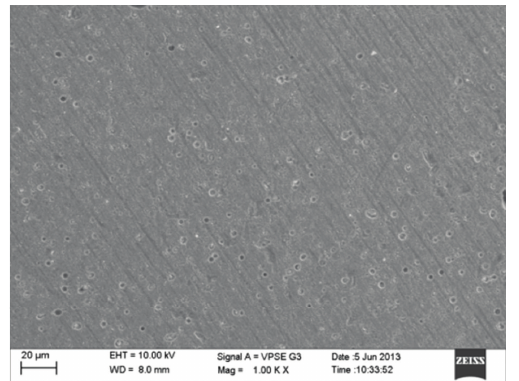
Figure12:SEMimageofthesurfaceofaluminumafter0.5 MH 3 PO 4 at 30 ∘ C in presence of 500 ppm of